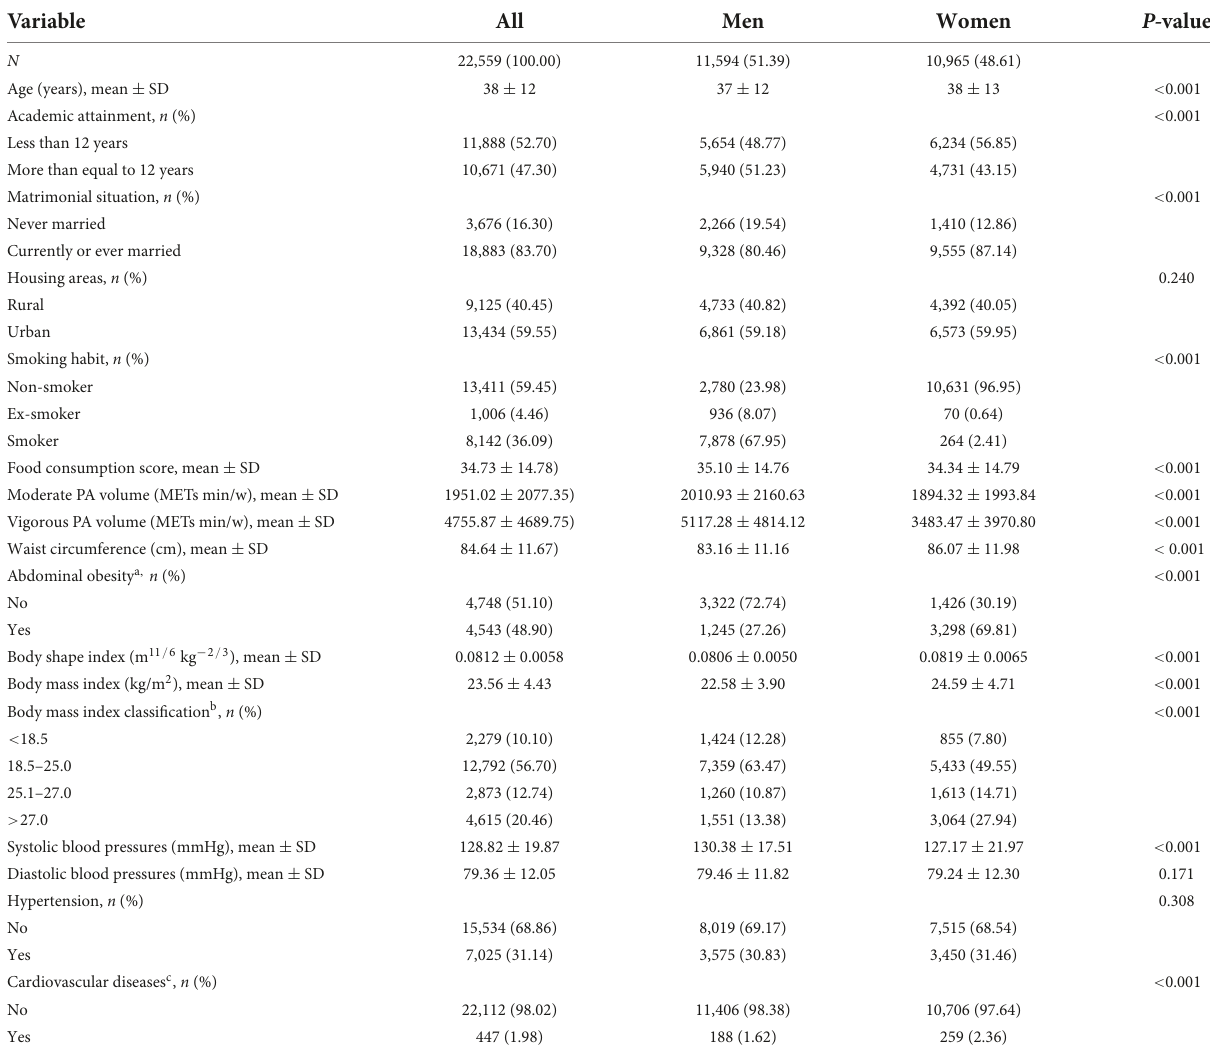
TABLE 1 Participants